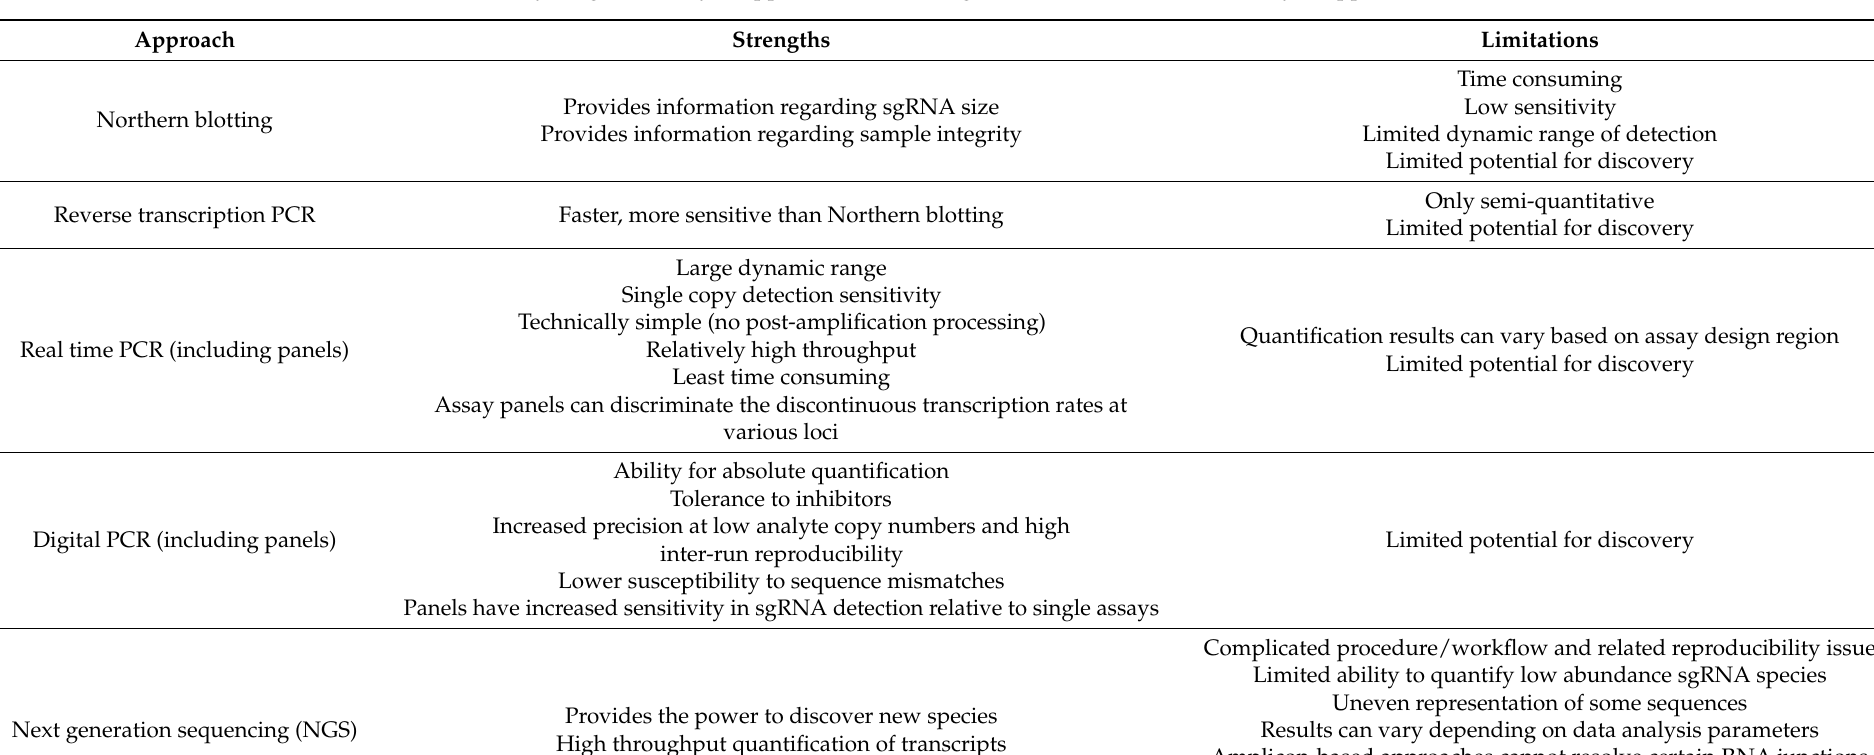
Table 1. Summary of sgRNA analysis approaches. The strengths and limitations of each analysis approach are